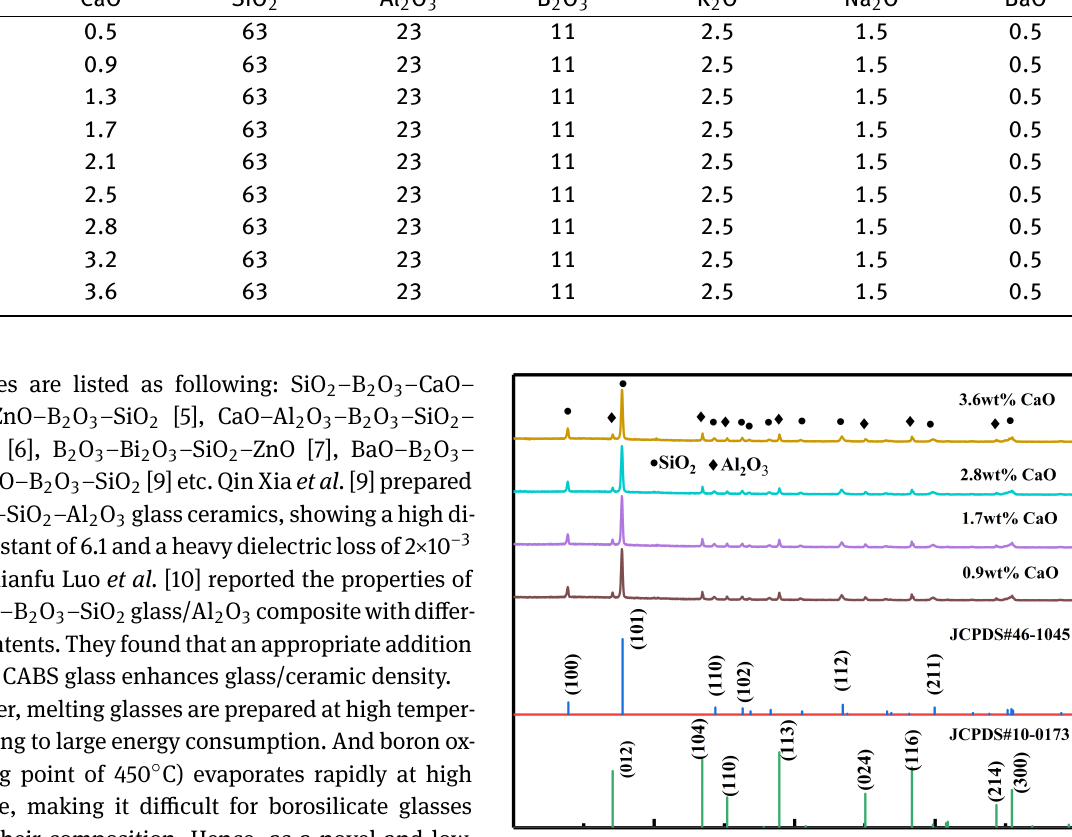
Table 1: Composition of different CaO content (mass fraction, wt %) Sample